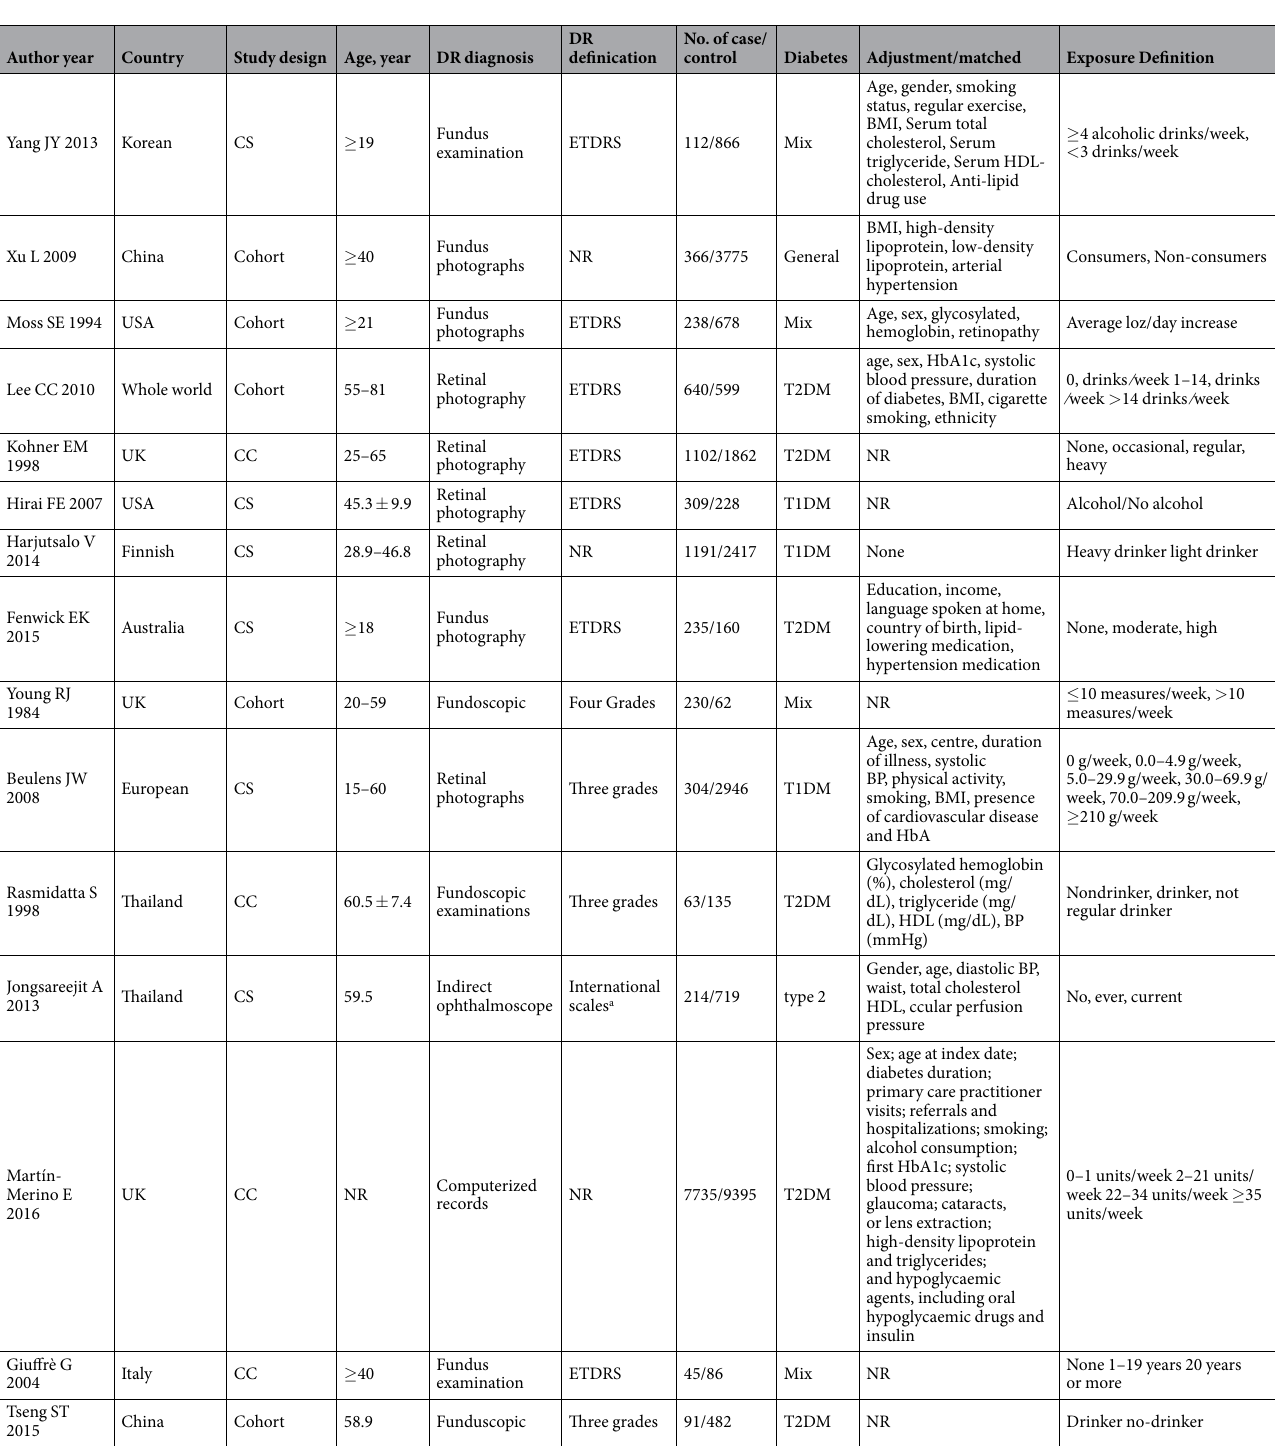
Table 1. Characteristics of Eligible Studies. NR: not reported; CC: case-control study; CS: cross-sectional study; T1DM: type 1 diabetes mellitus; T2DM: type 1 diabetes mellitus; HDL: high-density lipoprotein; BMI: body mass index; BP: blood pressure; ETDRS: Early Treatment Diabetic Retinopathy Study. a International clinical diabetic retinopathy and diabetic macular edema disease severity